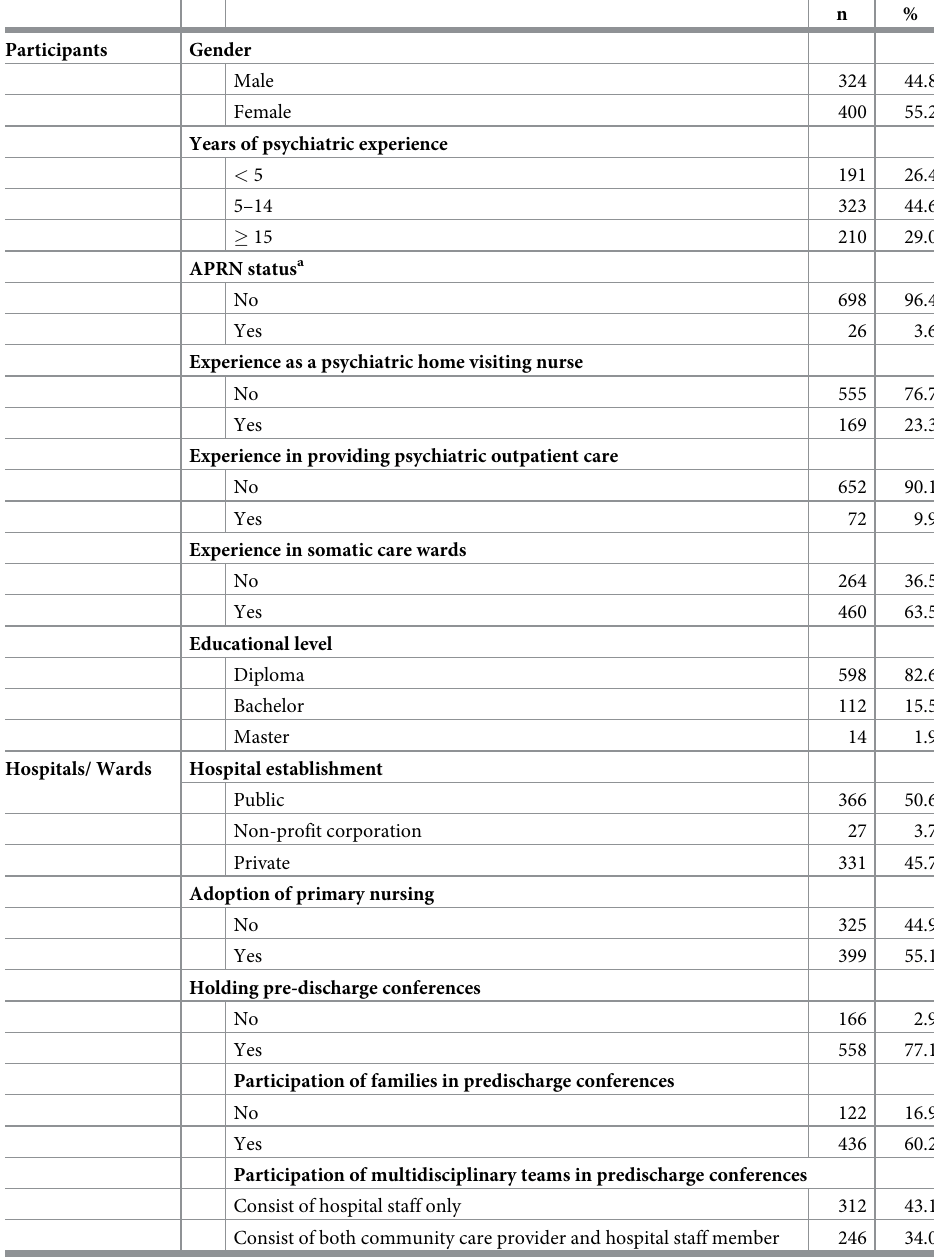
Table 1. Characteristics of the participants and features of the hospitals/wards in which they were working (n = 724).